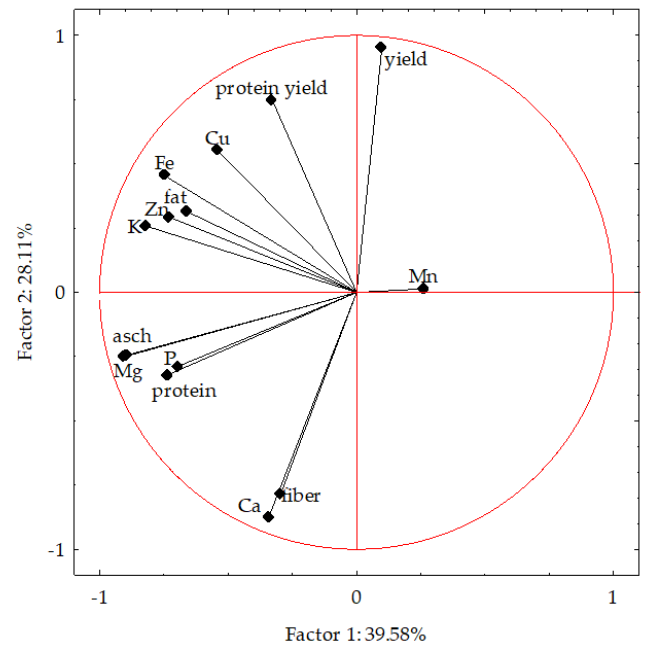
Figure 6. Principal component analysis (PCA) biplot of the distribution of the analyzed parameters.